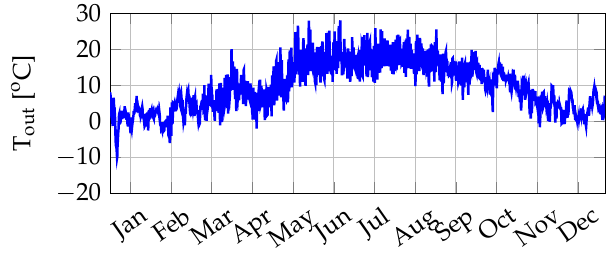
Figure 7. Outside temperature year 2017 in